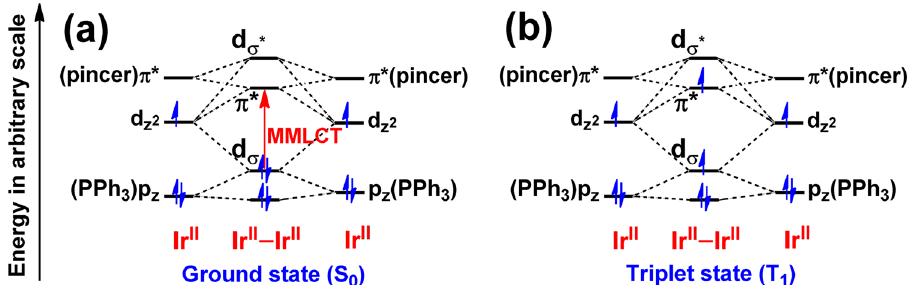
Fig. 7 Illustration of the origin and Ir – Ir bond wenkening in triplet excited state. Schematic frontier molecular orbital (FMO) diagrams of 1 – 3 in the ground ( a ) and the lowest-lying triplet ( b ) states. Note that the relative energy is an arbitrary value. Only the key orbitals with main contribution are shown.